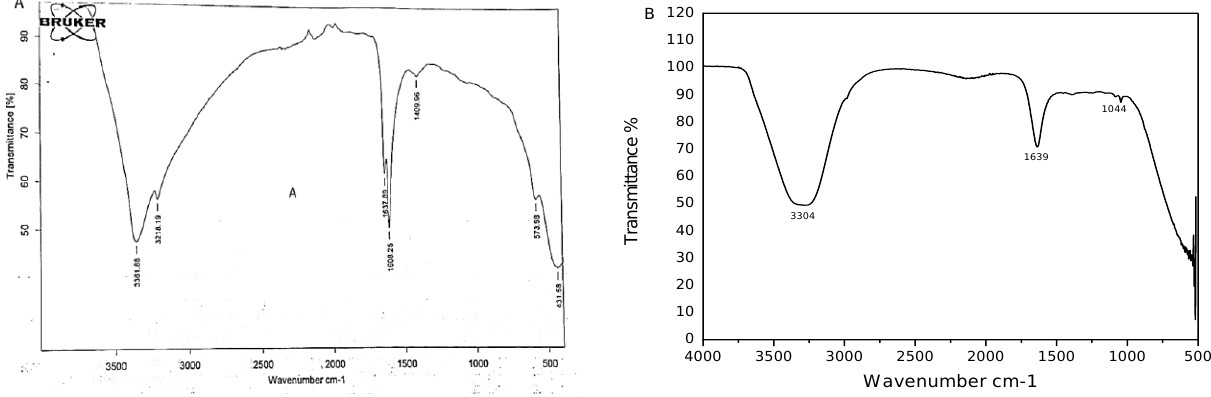
Figure 4. ( A ) FTIR spectrum of green ZnO NPs ( B ) FTIR spectrum of leaf extract of Azadirachta indica.